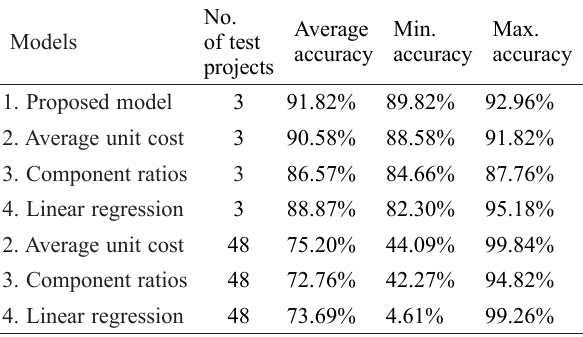
Table 12. Comparisons of evaluation results using various